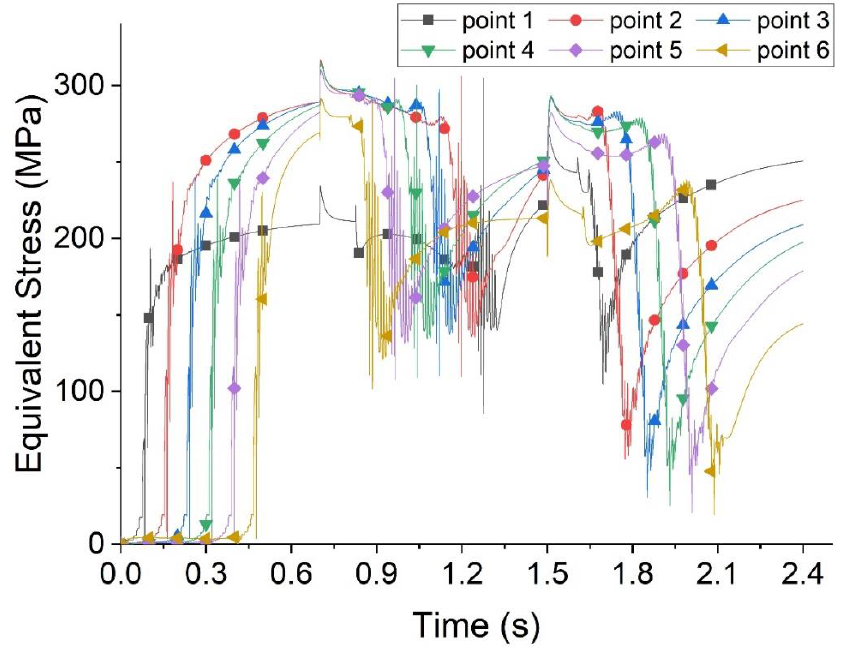
Figure 6. Results of residual stress changes in the first layer (6 points shown in Figure 2).